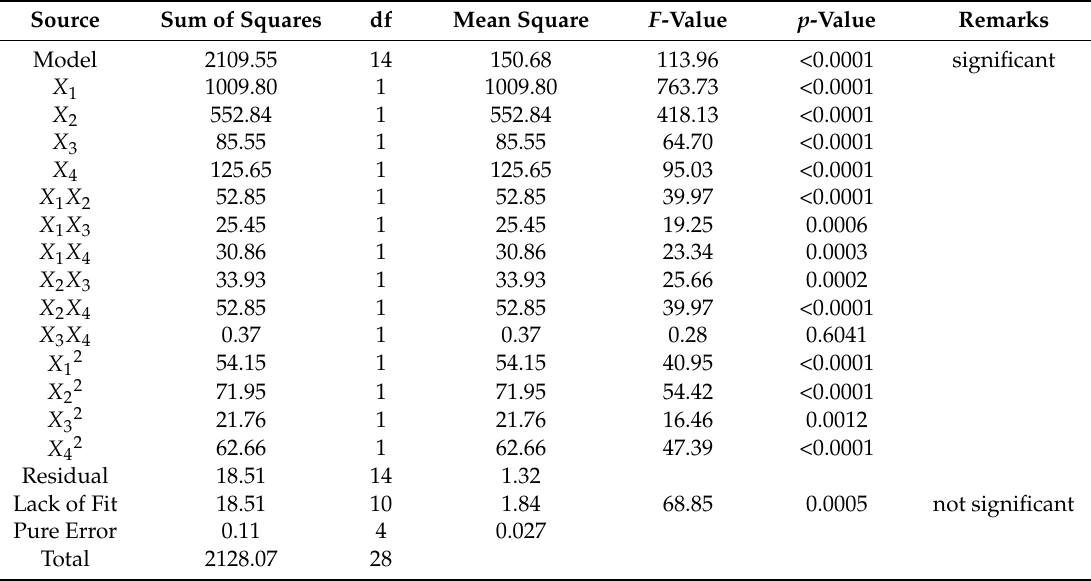
Table 3. ANOVA analysis and statistical parameters for the quadratic model.